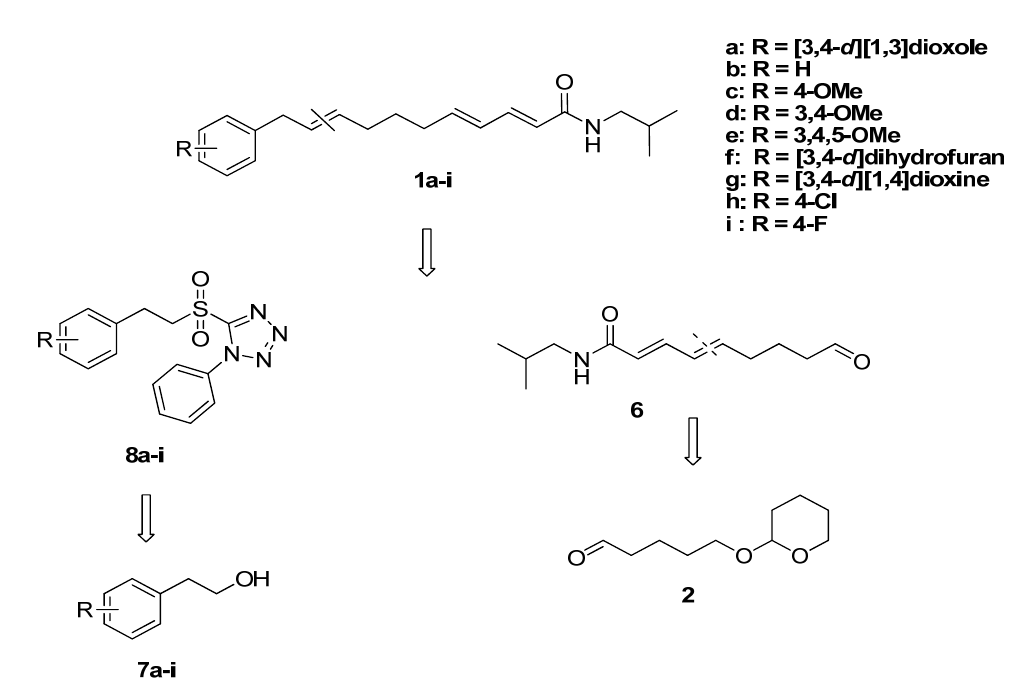
Scheme 1. Retro-synthetic analysis of laetispicine and its